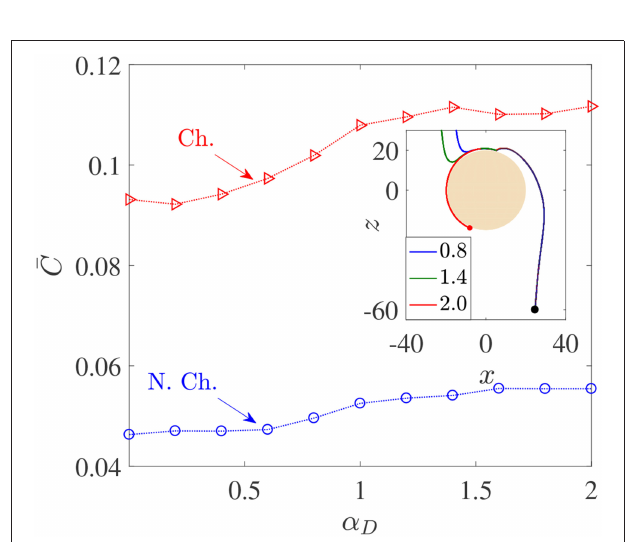
FIGURE 5 | Variation in average nutrient exposure, ¯ C , as a function of the dimensionless bacterial dipole strength α D , for chemotactic (Ch.) and non-chemotactic (N.Ch.) bacteria. The other parameters are: R = 45, K 1ρ = 0.0109, Sc = 1000, τ ∗ = 1. Inset: The trajectories of three chemotactic bacteria with different α D values (these are given in the legend). It can be seen that all three trajectories begin just outside the aggregate’s swept volume but are able to “chemotax” onto the surface. The amount of time each bacterium spends on the surface of the source depends on their dipole